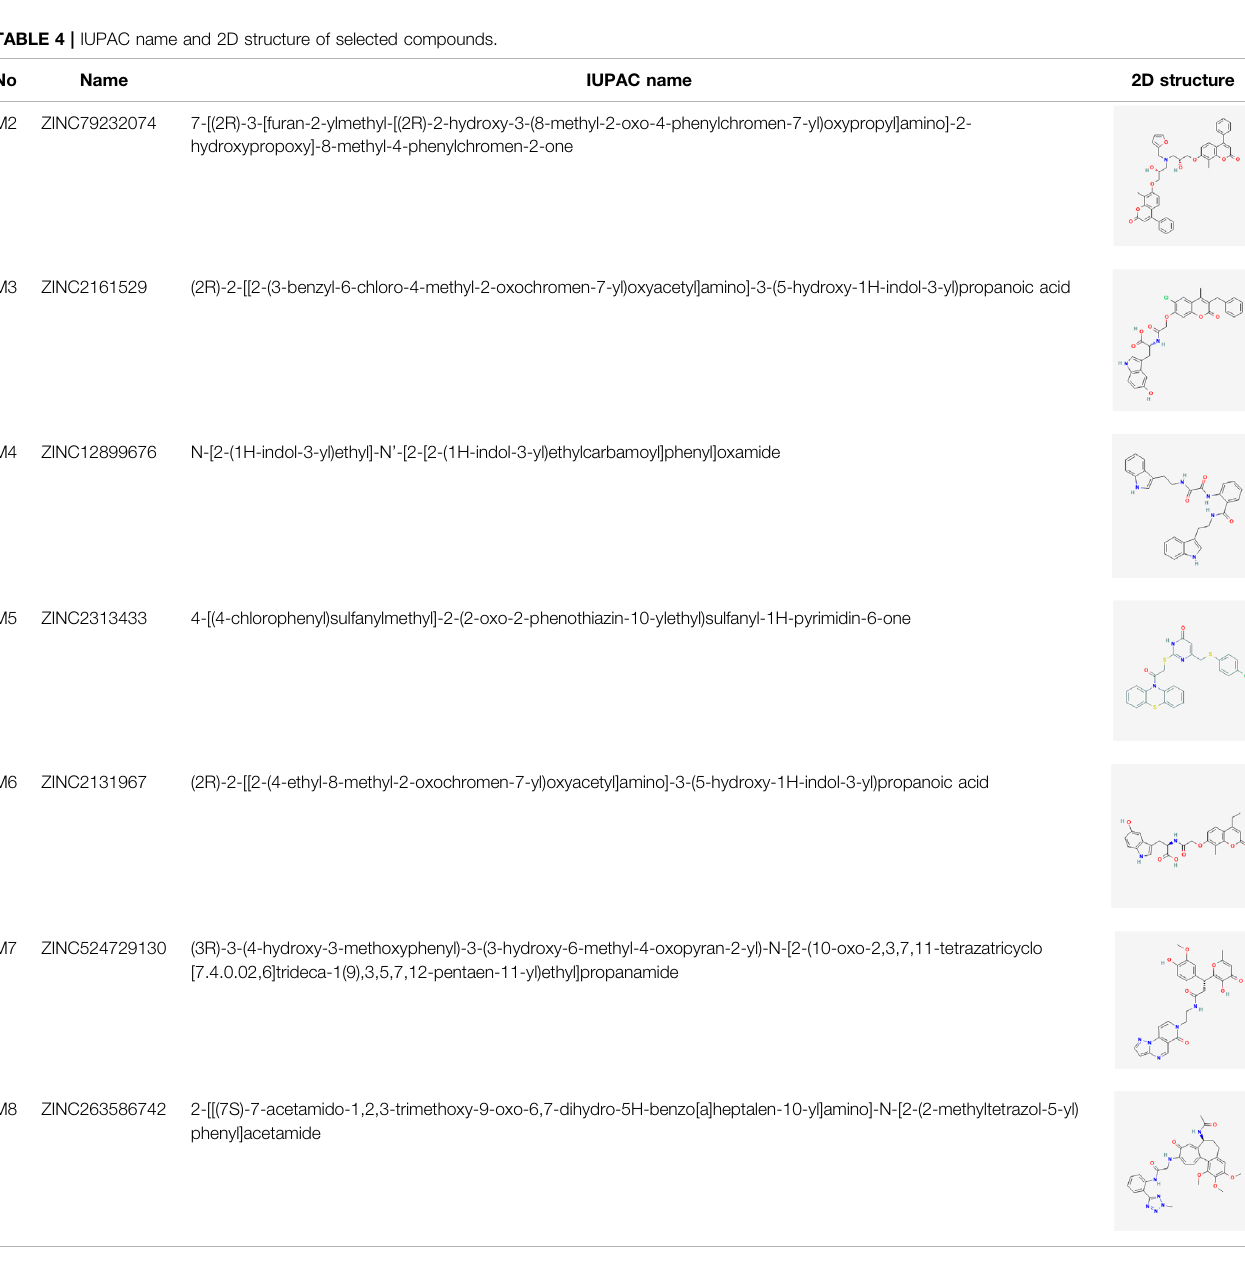
TABLE 4 | IUPAC name and 2D structure of selected